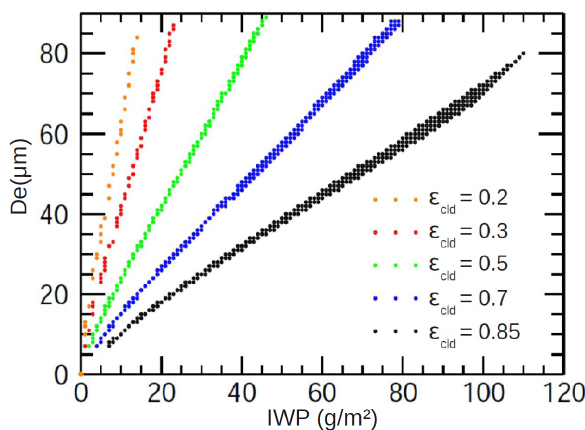
Fig. 2. Effective ice crystal diameter ( D e ) as a function of ice water path (IWP) for various simulated cirrus emissivities ( (cid:15) cld ) indicated in the legend. Each value of (cid:15) cld corresponds to the average of an interval of ± 0.05 around this value.